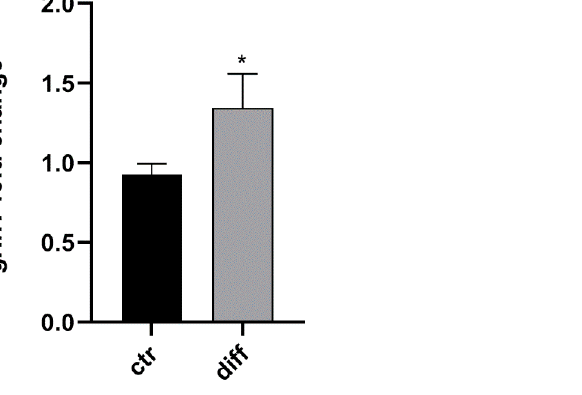
Figure 1. Grin1 gene expression in differentiated hippocampal neuron. The bar graphs show the mean + SEM of three independent experiments performed in triplicate. The statistically significant differences between experimental conditions and untreated control cells are shown by asterisks (* p <